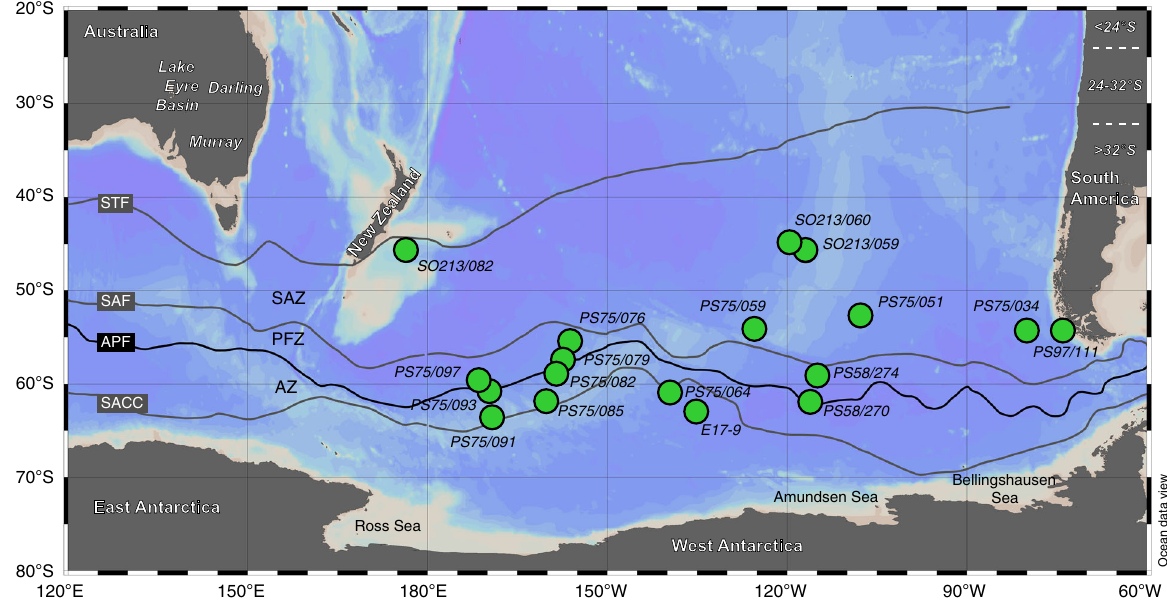
Fig. 1 Sample locations in the South Paci fi c. Main terrestrial potential source areas (PSAs) indicated with white labels. South American dust sources are grouped into latitudinal bands. In the text, PSAs between 24 and 32°S are also referred to as Central South America, whereas Southern South America describes the PSAs south of 32°S. Southern Ocean fronts from ref. 94 . STF: Subtropical Front. SAF: Subantarctic Front. APF: Antarctic Polar Front. SACC: Southern ACC Front. SAZ: Subantarctic Zone. PFZ: Polar Frontal Zone. AZ: Antarctic Zone. Map created with Ocean Data View 95 .